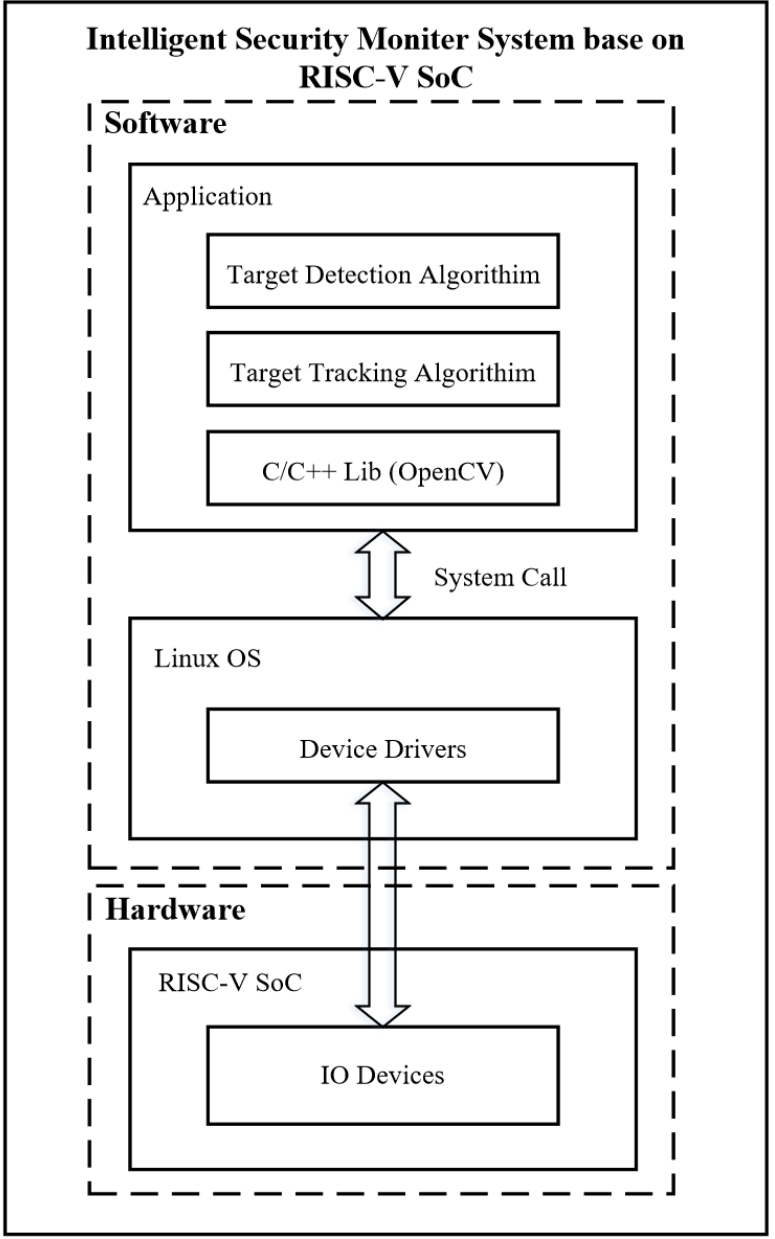
Figure 1. Overall system